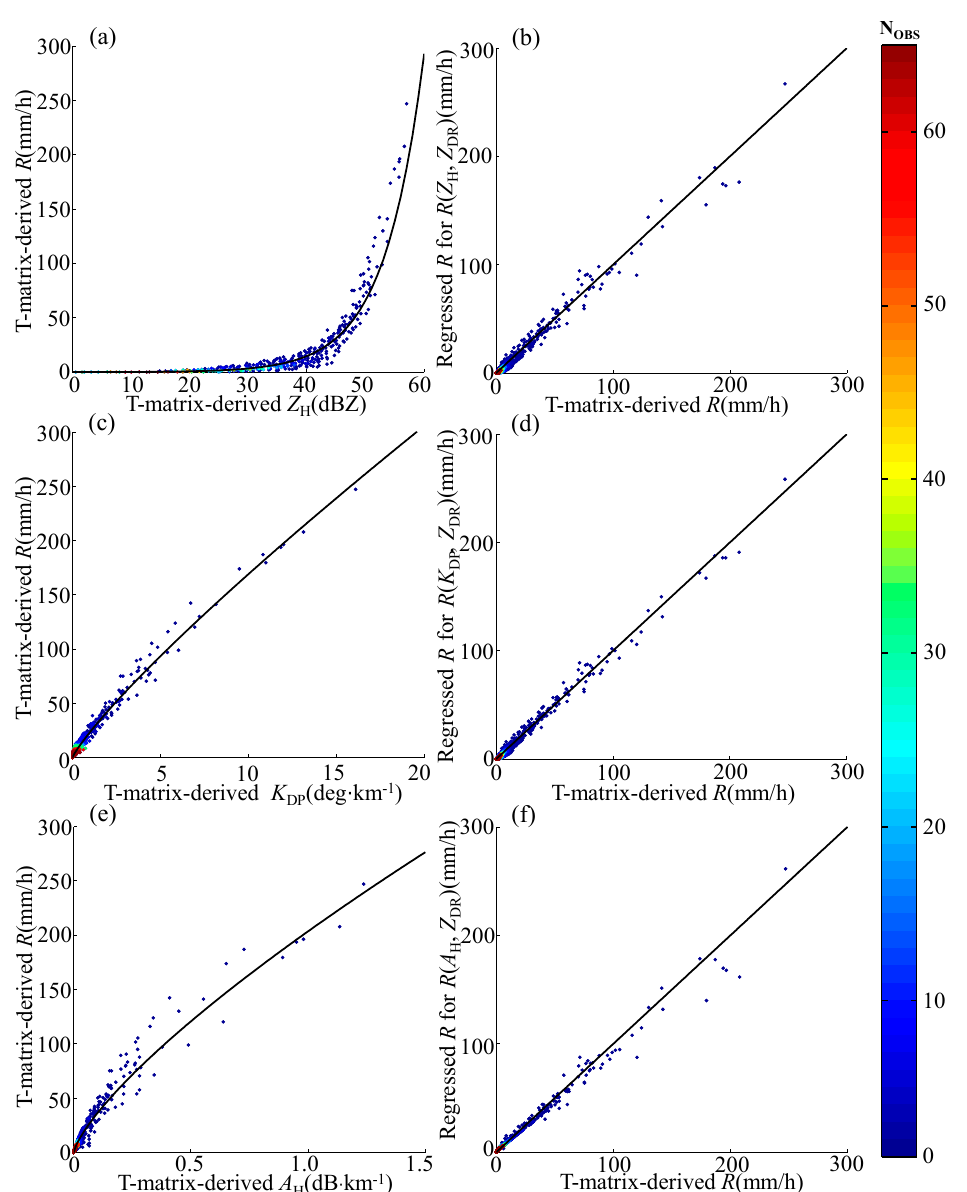
Figure 4. Scattergram between T -matrix-derived polarimetric radar variables, as well as estimated/ regressed R based on the simulated radar variables using the raindrop size distribution (DSD) data collected on 01 June 2016: ( a ) R(Z H ) ; ( b ) R ( Z H , Z DR ); ( c ) R ( K DP ); ( d ) R ( K DP , Z DR ); ( e ) R ( A H ); ( f ) R ( A H , Z DR ). The black lines in (a–c) represent Equations (3a), (3c), and (3e), respectively. T -matrix-derived R stands for R calculated directly from the DSD data.